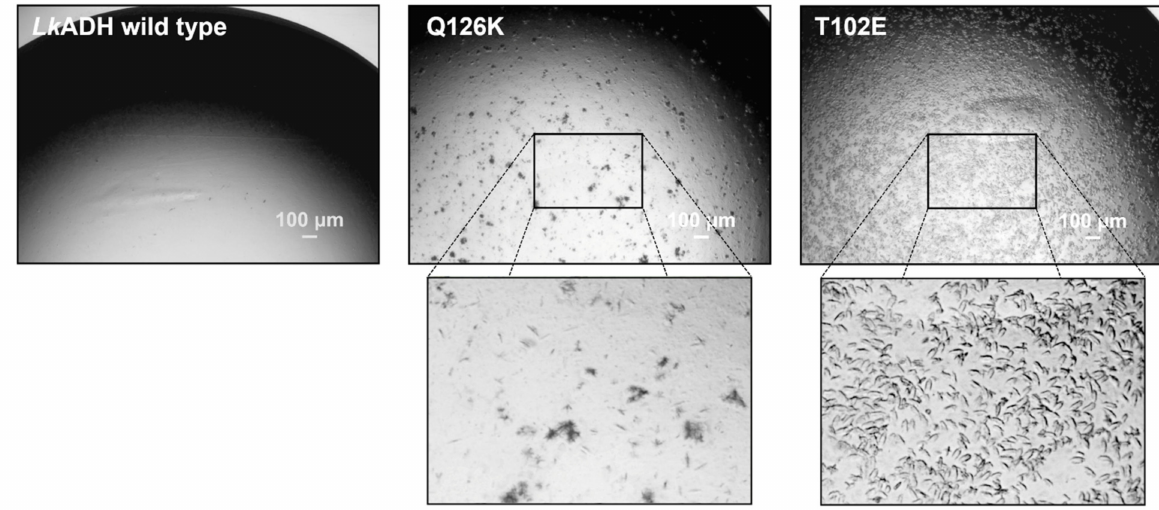
Figure 6. Photomicrographs of Lk ADH wild type and mutants Q126K and T102E after 48 h of crystallization from clarified E. coli cell lysate without dialysis in stirred tank reactors (c 0 = 5 g L − 1 , V = 5 mL, n Stirrer = 150 rpm, 20 ◦ C, 150 g L − 1 PEG MME